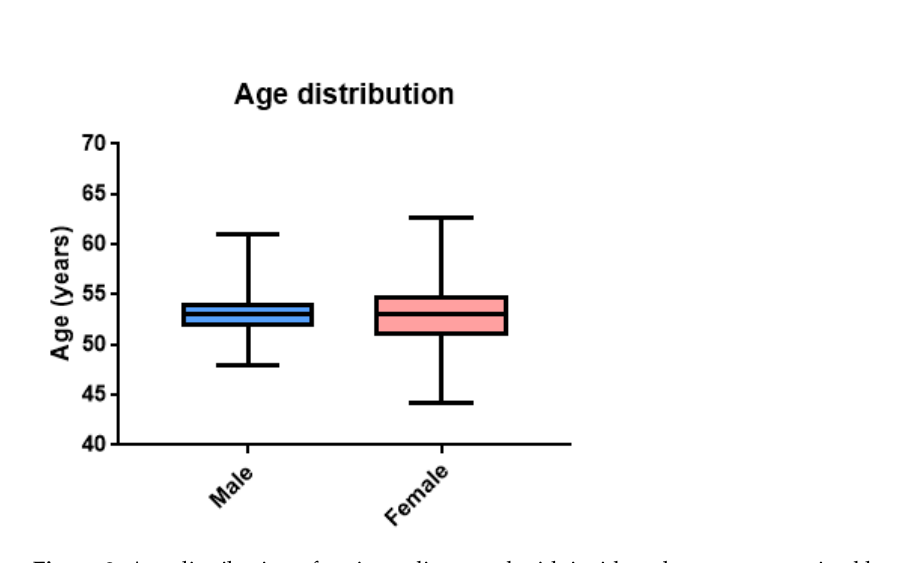
Table 1. Incidental cancer by histological type and gender